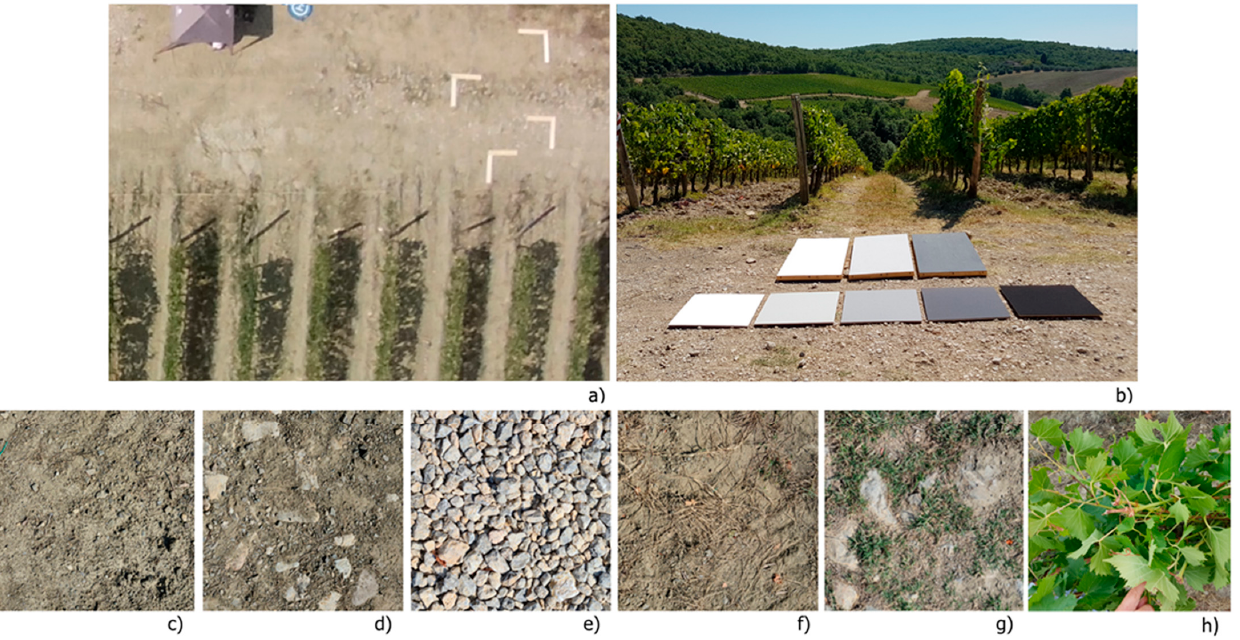
Figure 3. The ground targets position in the area close to the study vineyard ( a ). In detail the figure reports the reference reflectance panels used for radiometric correction ( b ), and targets related to bare soil ( c ), bare-stony soil ( d ), stony soil ( e ), soil with dry grass ( f ), partially grass covered soil ( g ) and canopy ( h